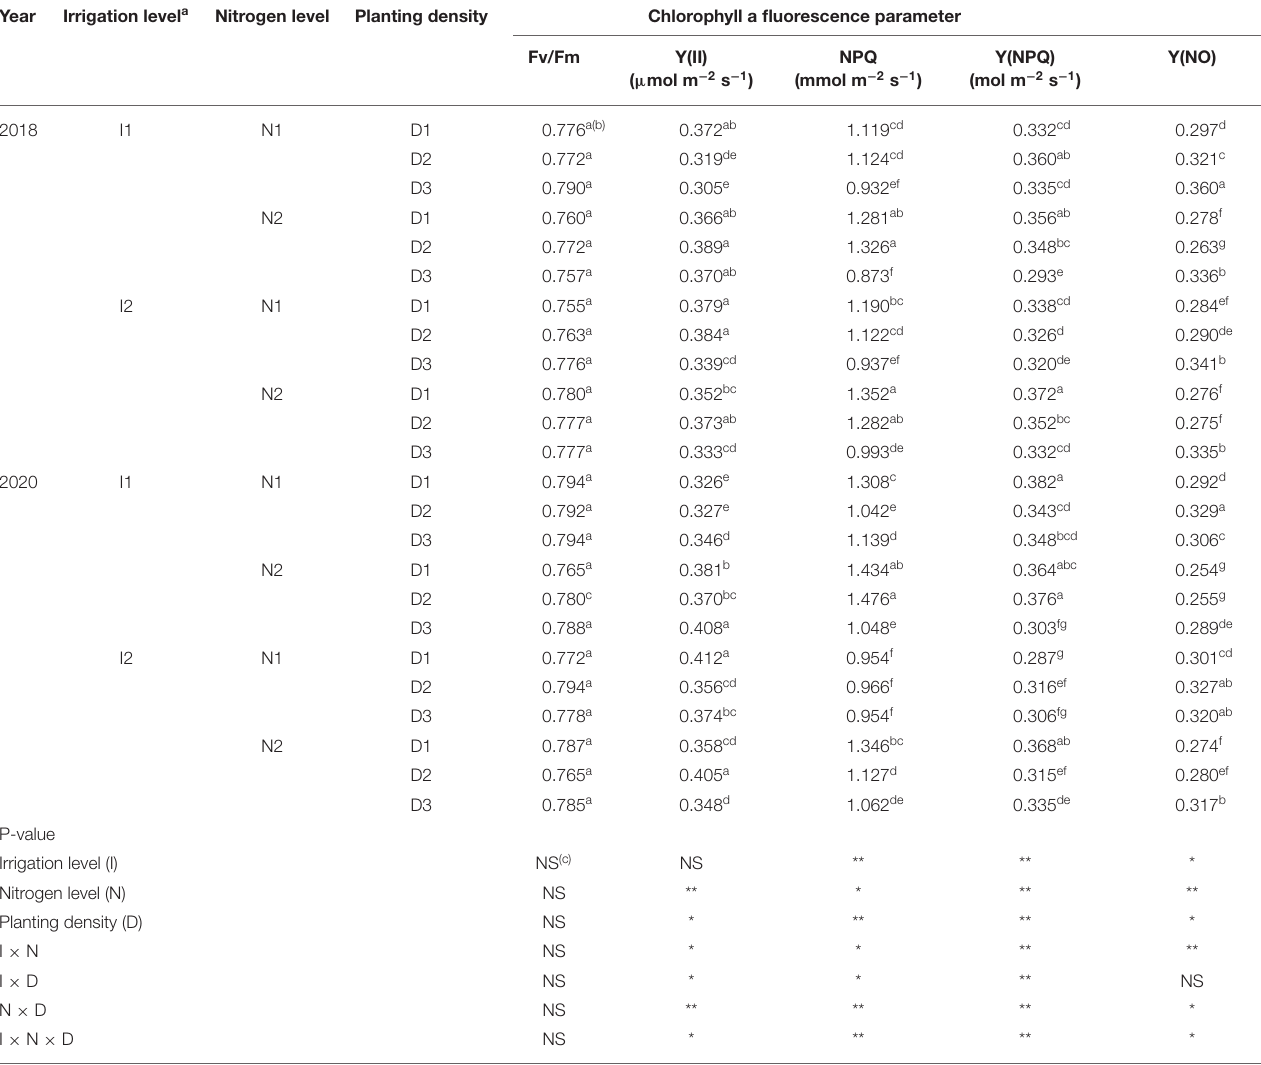
TABLE 3 | Maximal photochemical efficiency of PSII (Fv/Fm), actual photochemical efficiency of PSII (Y(II)), dissipation of excess energy (NPQ), quantum yield of regulated non-photochemical energy loss (Y(NPQ)), and quantum yield of non-regulated non-photochemical energy loss (Y(NO)) of maize at silking stage as affected by irrigation and nitrogen levels and planting density in 2018 and 2020 at arid irrigated